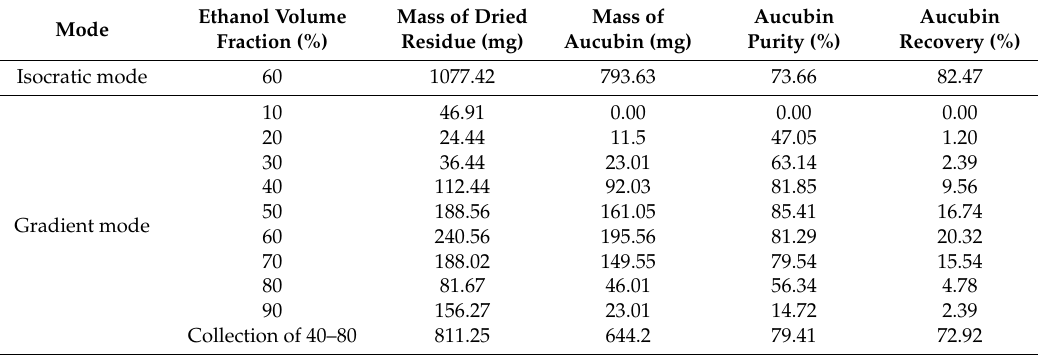
Table 3. Results of elution in isocratic and gradient modes of aucubin on a column packed with HPD850